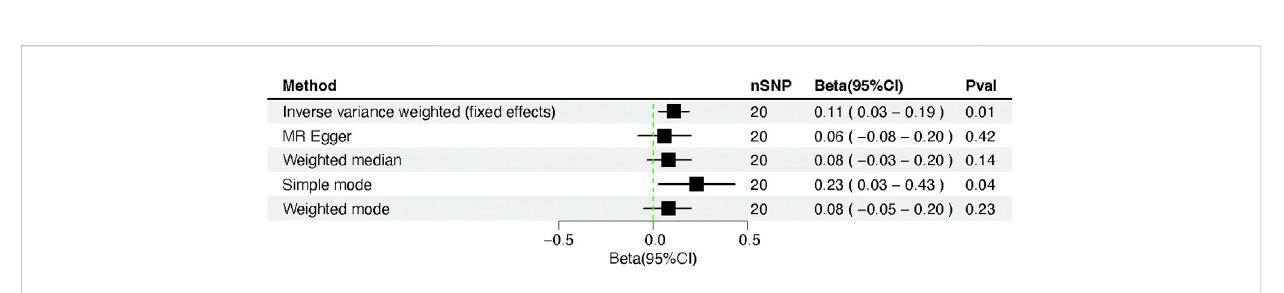
FIGURE 4 Forest plot of Mendelian randomization analysis between COVID-19 severity (severe respiratory symptoms) and cardiac injury